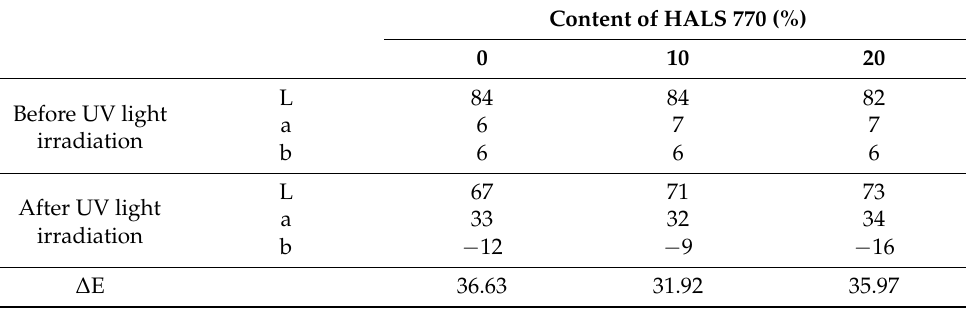
Figure 11. The effect of HALS 770 on the absorbance of the microcapsules. Table 2. The color parameter of microcapsules with different content of HALS